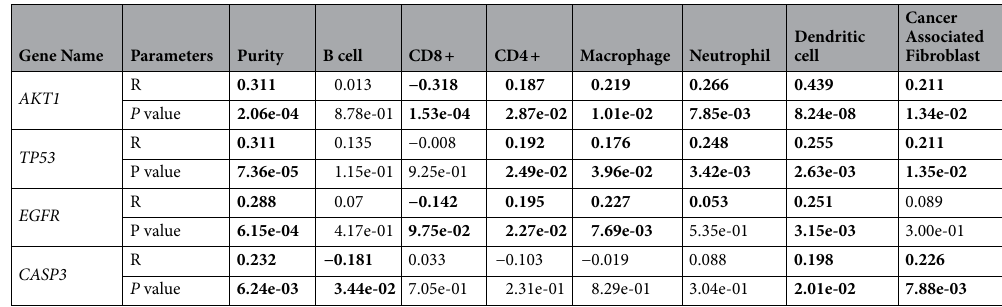
Table 3. Immune cell infiltration related to the expression levels of AKT1 , TP53 , EGFR , and CASP3 . Significant values are in